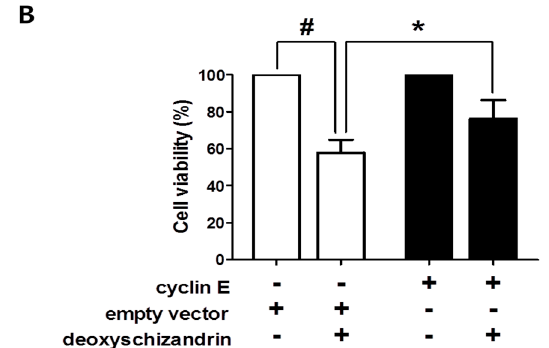
Figure 3. Involvement of cyclin E in deoxyschizandrin-induced cell cycle arrest in A2780 cells: ( A ) Effect of deoxyschizandrin on cyclin E expression was measured using Western blotting. A2780 cells were treated with the indicated concentration of deoxyschizandrin (15, 30, and 60 µ M) for 48 h. β -Actin was used as an internal control. Band images are representatives of three individual experiments and the results of densitometric analysis represent the mean ± SD of three independent experiments. * p < 0.05 vs. the control group; ( B ) Involvement of cyclin E in deoxyschizandrin-induced cell cycle arrest was examined using MTT assay. A2780 cells were transfected with cyclin E expression vector and were treated with deoxyschizandrin (30 µ M) for 48 h. The values represent the mean ± SD of results from three independent experiments. # p < 0.05 vs. the control group; * p < 0.05 vs. the treated group transfected with empty vector.